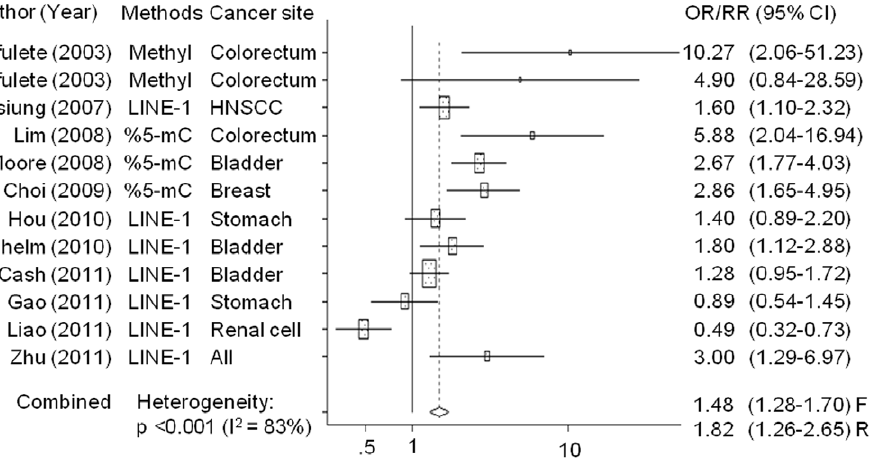
Figure 2. Forest plot of the association between cancer risks and global DNA hypomethylation in peripheral blood leukocytes. Colorectal A: Colorectal Adenoma, Methyl: Methyl acceptance assay, LINE-1: Long interspersed nuclear elements, and %5-mC: Percentages of 5- methylcytosine. F: Fixed effects model, R: random effects model. The horizontal lines through the boxes represent 95% confidence intervals (CI). The centers of the boxes are situated in the point estimate (OR/RR), and the bigger boxes mean studies have relatively greater influence in the summary estimates.